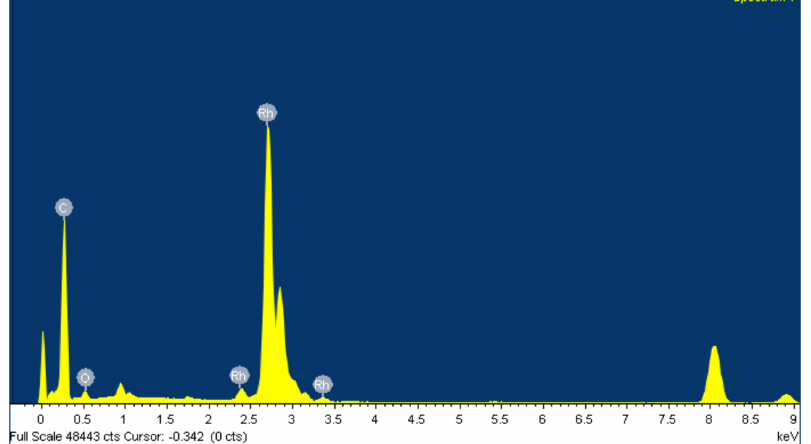
Figure 3. EDS spectrum of M2 .